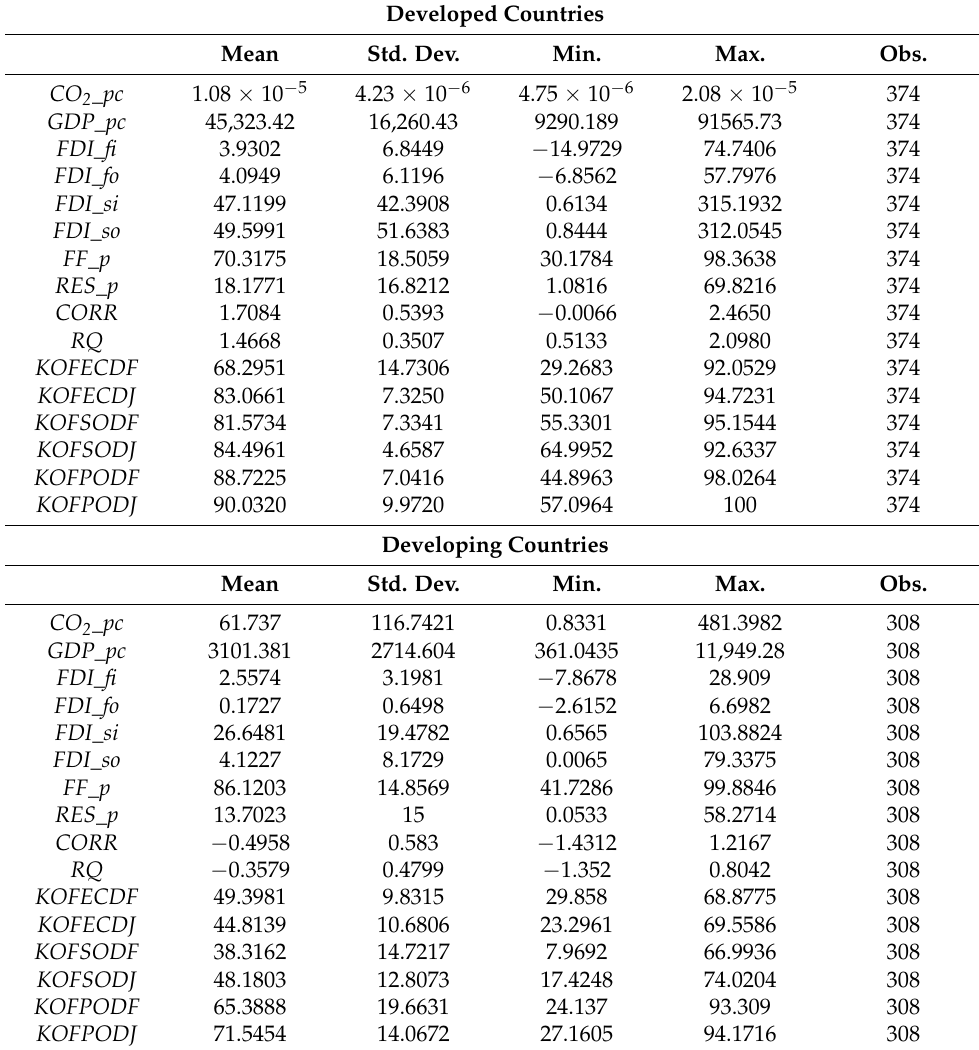
Table 3. Descriptive statistics from 1996 to 2017 (CO 2